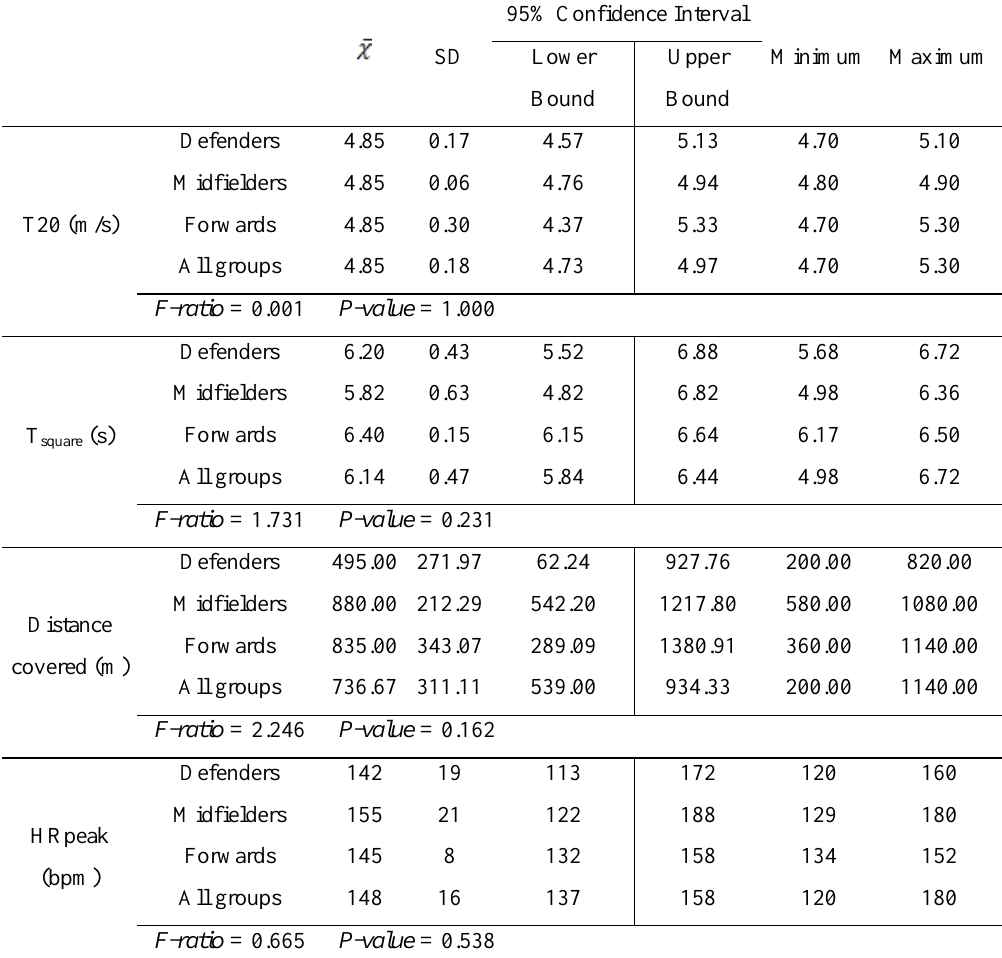
Table 3. Physical characteristics of Brazilian amputee soccer